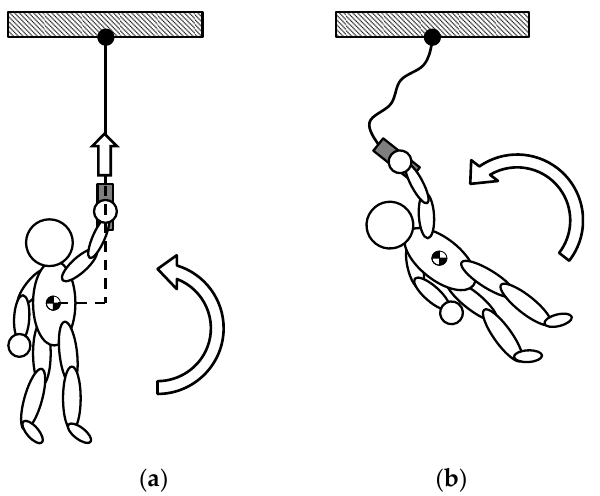
Figure 2. Drawbacks of the TSMD. ( a ) Moment of force; ( b ) Rotational motion.